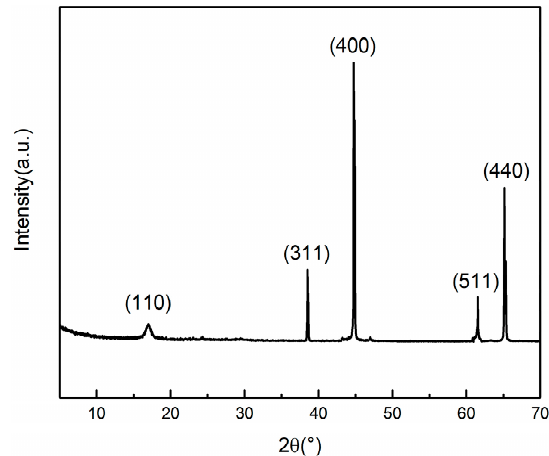
Figure 3. XRD patterns of the Al 2 O 3 coatings on zinc substrate.